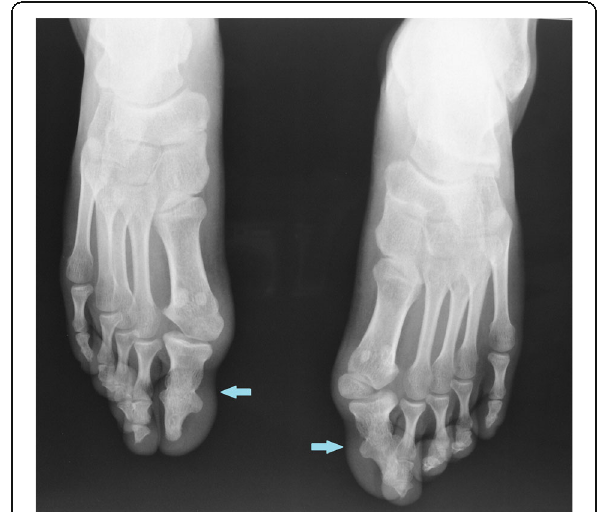
Fig. 4 Dorso-plantar radiograph of bilateral feet showing hallux valgus deformity with macrodactyly and fusion of the halluces ’ interphalangeal joint